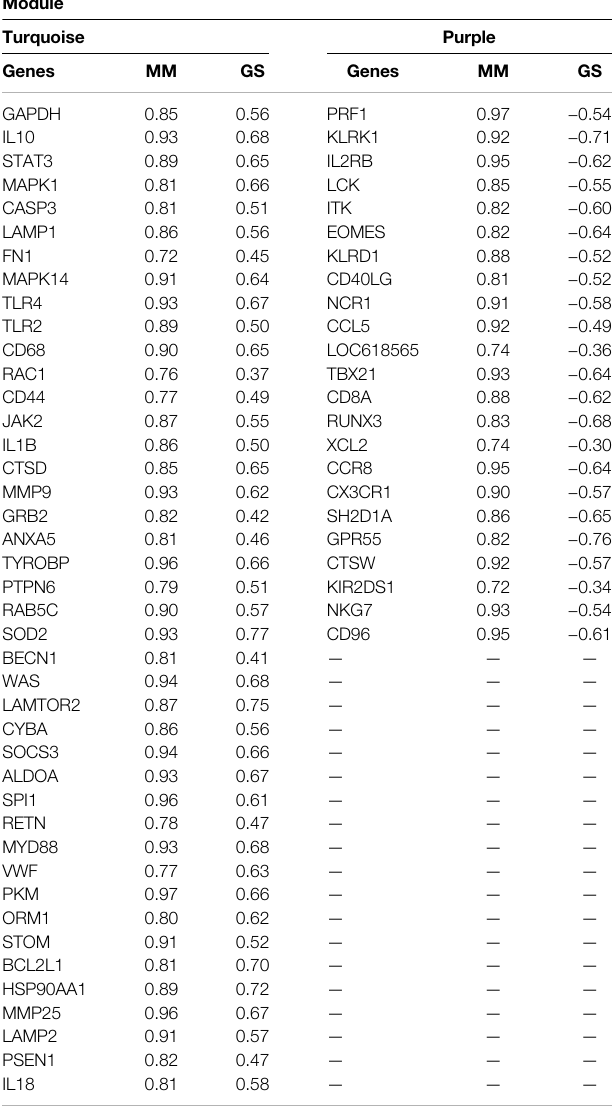
TABLE 1 | List of the hub – hub genes in the turquoise and purple modules as signi fi cant highly correlated and biologically related modules with bovine respiratory disease (BRD) along with their module memberships (MM) and gene signi fi cance (GS) for rectal temperature (identi fi ed by module – trait relationships